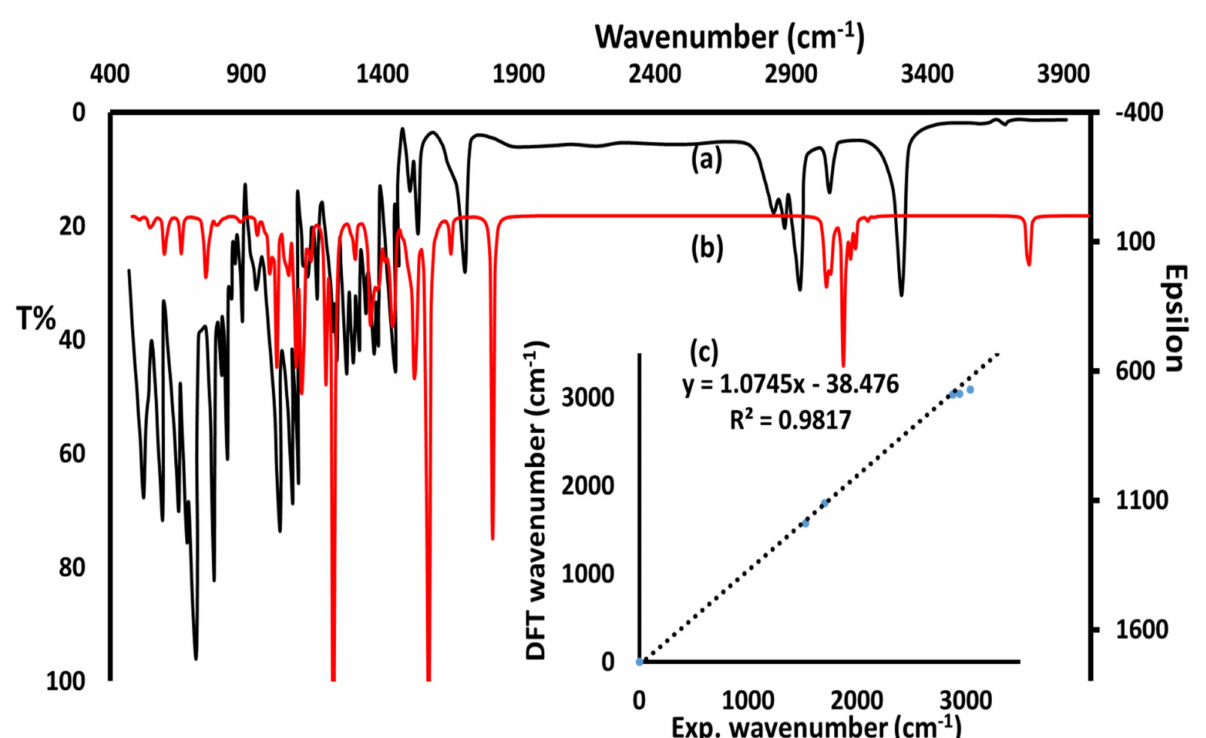
Figure 7. ( a ) Exp. FT-IR, ( b ) DFT-IR, and ( c ) Exp./DFT-IR correlation.